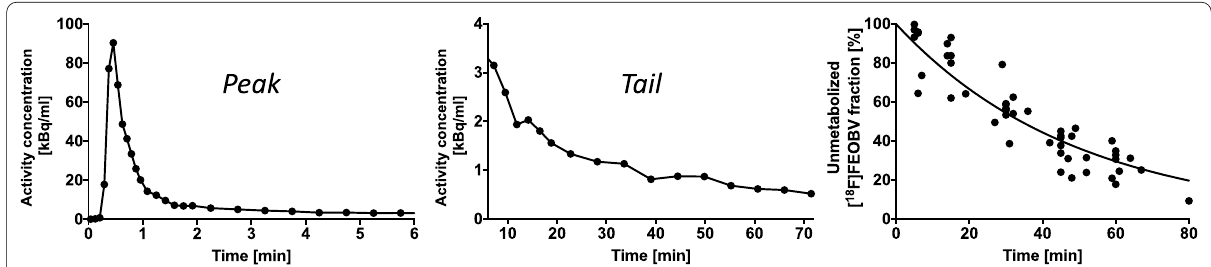
Fig. 1 Example of an image-derived arterial plasma input function from aorta showing the initial peak (left), tail (middle), and the common metabolite correction curve ( Y 100% * e ( − 0.2026*X) ) (right). The arterial plasma input function shown is corrected for hematocrit, red blood cell = binding, and metabolites (see text for